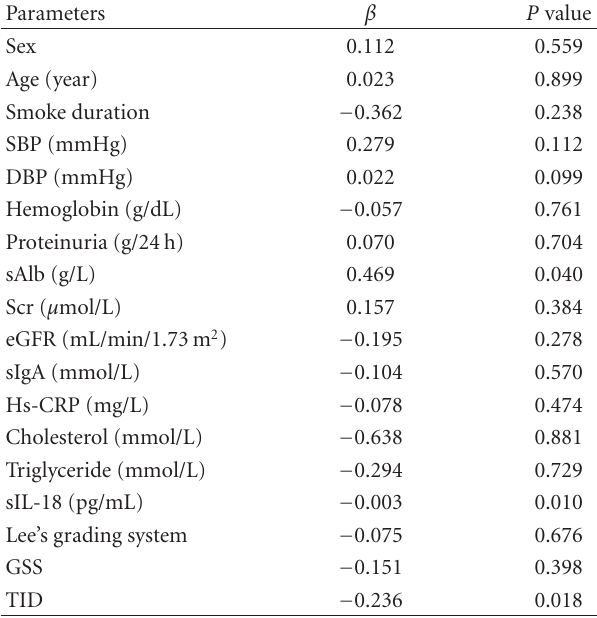
Table 3: Multivariate regression model to evaluate correlated fac- tors with responsiveness to steroid